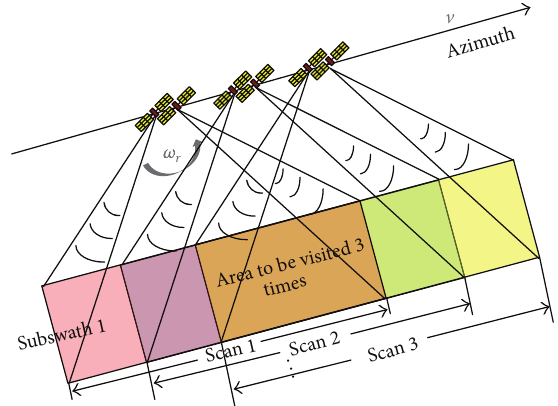
Figure 1: Scanning in one of the subswaths in spaceborne WAS mode with three revisits.